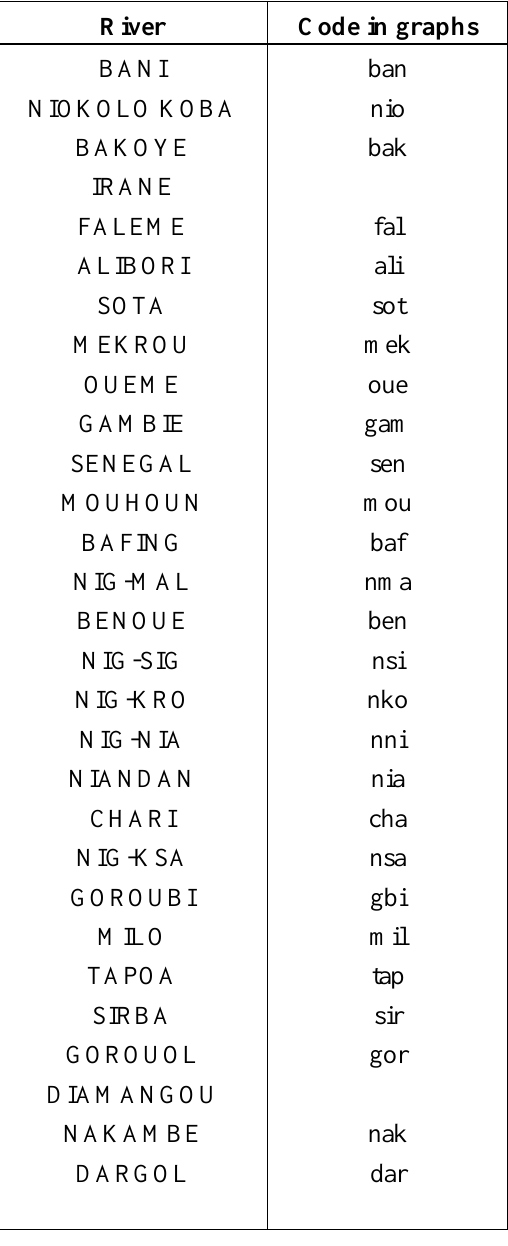
Table 7 . List of the 29 basins analyzed and the corresponding code in the figures of the PCA (principal component analysis; Irane and Diamangou are not used in the PCA analysis ).